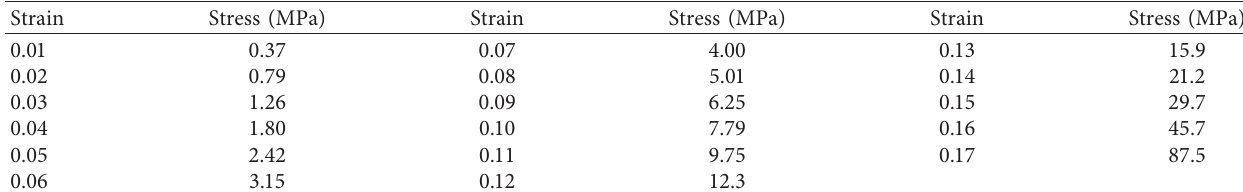
Table 3: Stress-strain relation of rock mass in the double-yield model goaf.